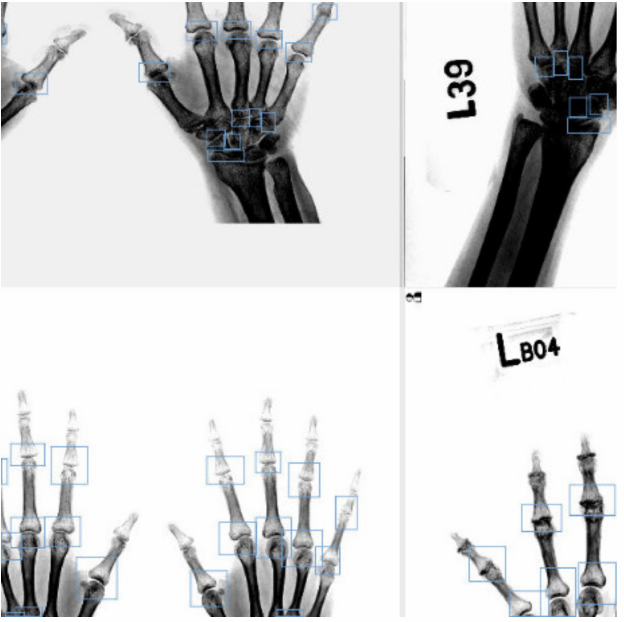
Figure 3. Example of an image after using a mosaic as the input